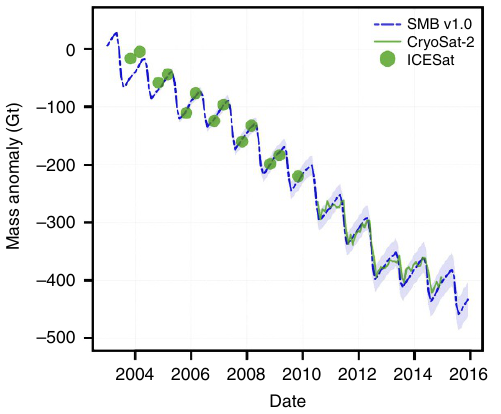
Figure 2 | Contemporary Greenland’s GICs mass anomaly. Comparison of Greenland’s GICs-integrated mass anomaly (2004–2015) derived from ICESat (green dots)/CryoSat-2 (green line) altimetry with the downscaled SMB v1.0 (dashed blue line). The light blue belt represents the estimated uncertainty of the downscaled SMB product.